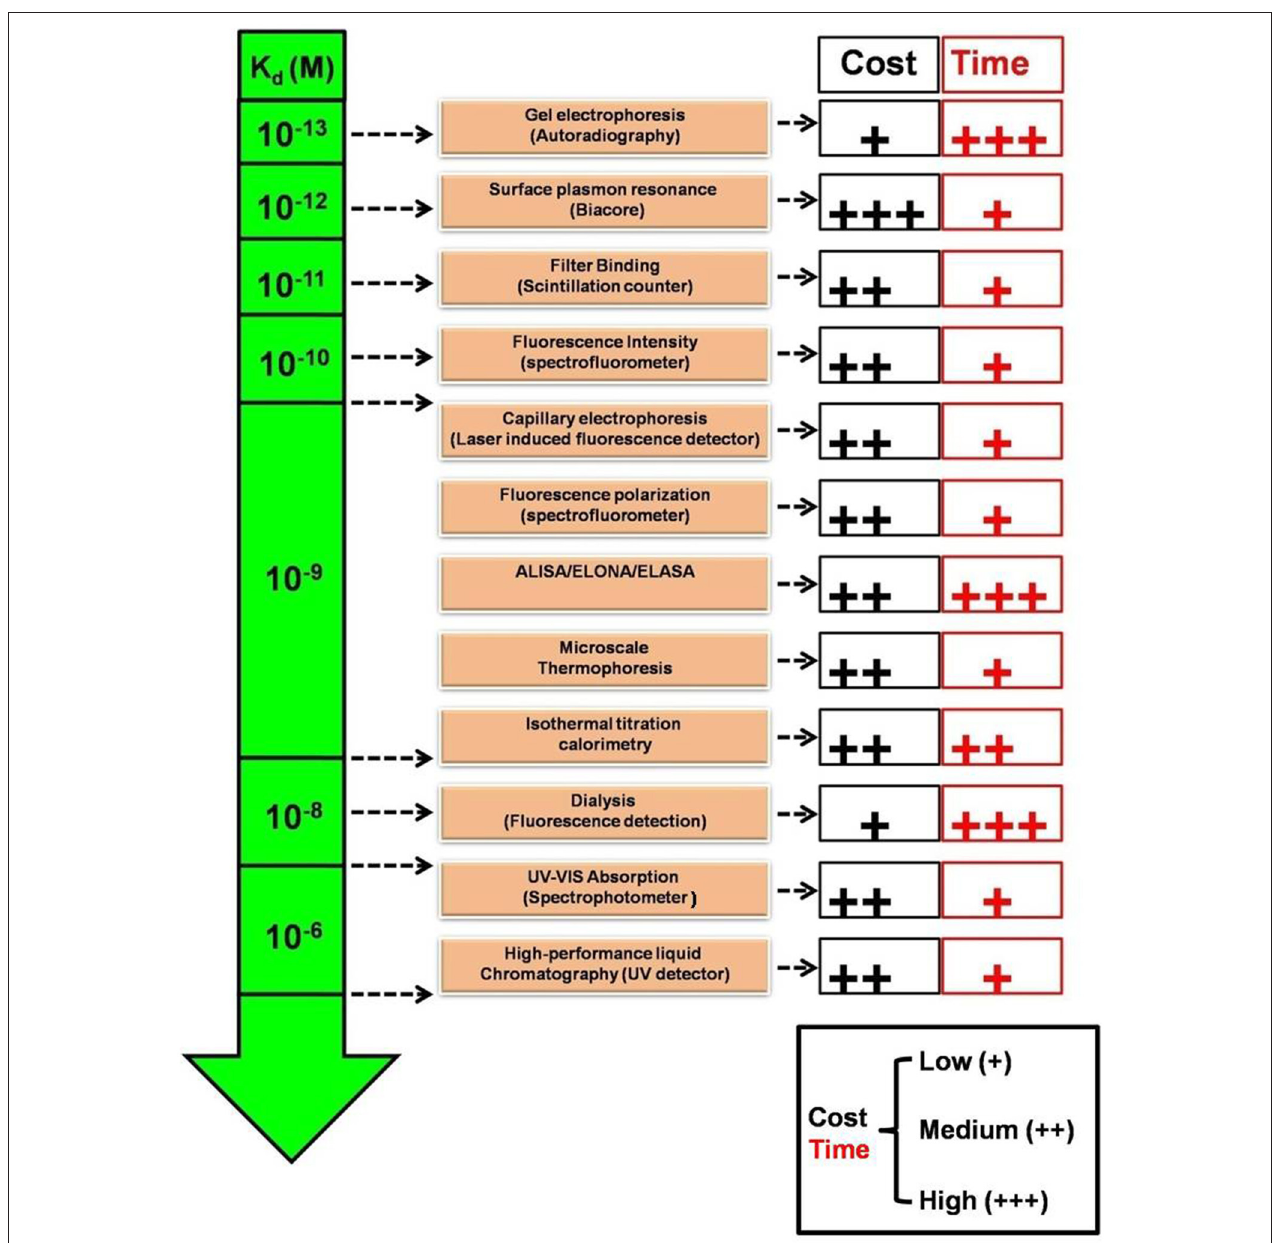
FIGURE 2 | Comparison of relative sensitivities, turnaround time and cost of various K d estimation techniques. K d , Apparent dissociation constant (Molar); UV-Vis, Ultraviolet-Visible; ALISA, Aptamer-linked immobilized sorbent assay; ELONA, Enzyme-linked oligonucleotide sorbent assay; ELASA, Enzyme-linked aptamer sorbent